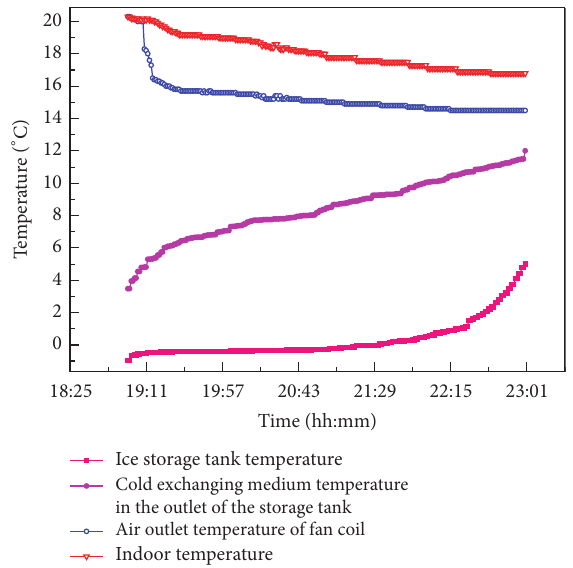
Figure 15: Temperatures change of exchanging cold and supplying cold